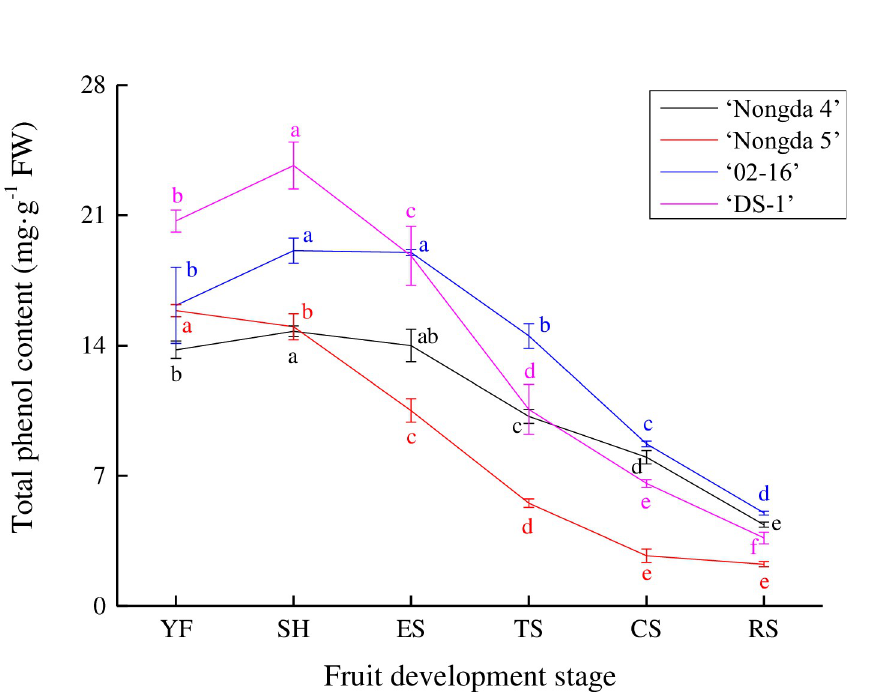
Fig 2. Dynamic change of total phenol content in Prunus humilis fruits. Note: The same color letters indicate significance at P < 0.05. FW, Fresh weight; YF, Young fruit stage; SH, Stone hardening stage; ES, Expension stage; TS, Turning stage; CS, Coloring stage; RS, Ripening